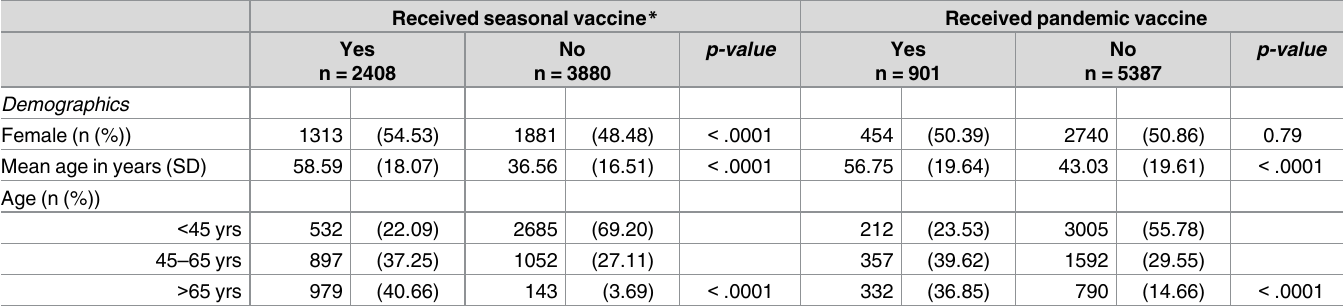
Table 2. Main characteristics of cases occurring between 1 June 2009and 30 June 2013 by vaccination